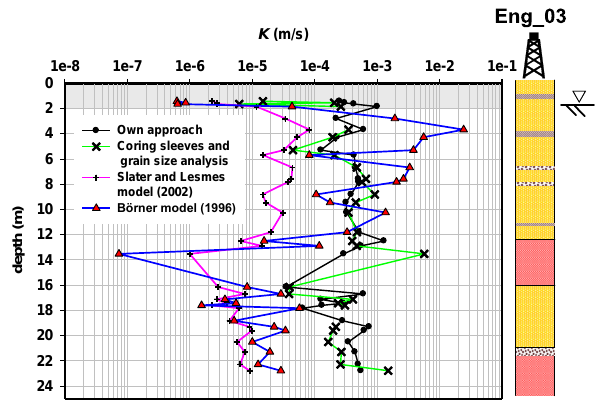
Fig. 9. Log–log plot of the measured resistivity versus K of nine core samples from the first aquifer (see Fig. 1). Green solid circles (left) Fig. 9. Log-log plot of the measured resistivity versus the hydraulic conductivity ( K ) of nine core 192 denote real resistivity parts ( ρ 0 ), while the black circles (right) represent imaginary ( σ 00 ) conductivity parts. samples from the 1 st aquifer (see Fig. 1). Green solid circles (left) denote real resistivity parts 193 ( ρ ʹ ), while the black circles (right) represent imaginary ( σ ʹ ʹ ) conductivity parts. 194